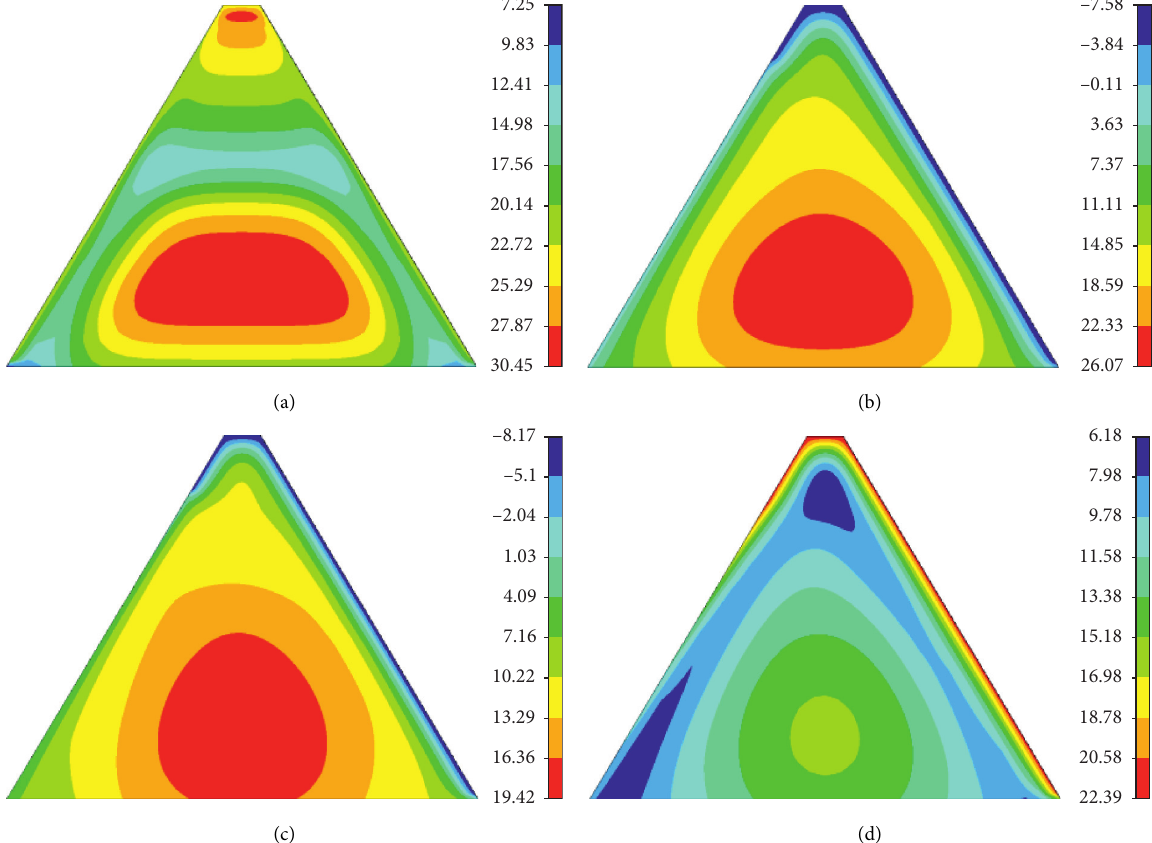
Figure 9: Distribution diagram of temperature during construction and operation (unit: ° C). (a) 380d. (b) 1000d. (c) 2000d. (d)